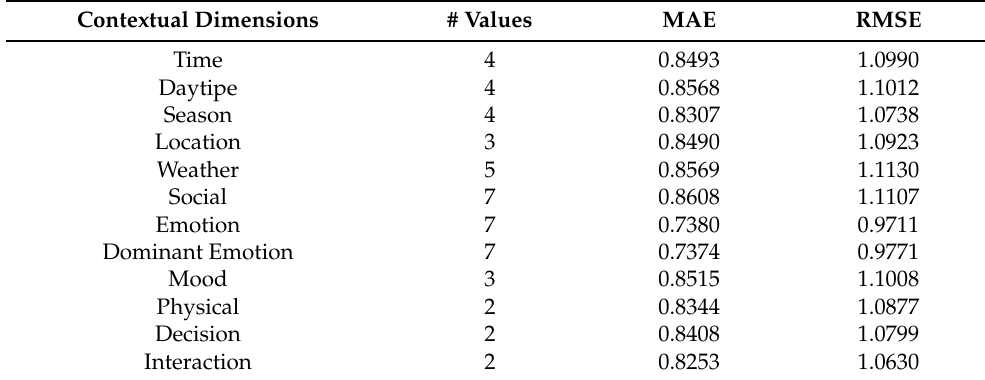
Table 7. Results related to single contexts of the LDOS-CoMoDa dataset.